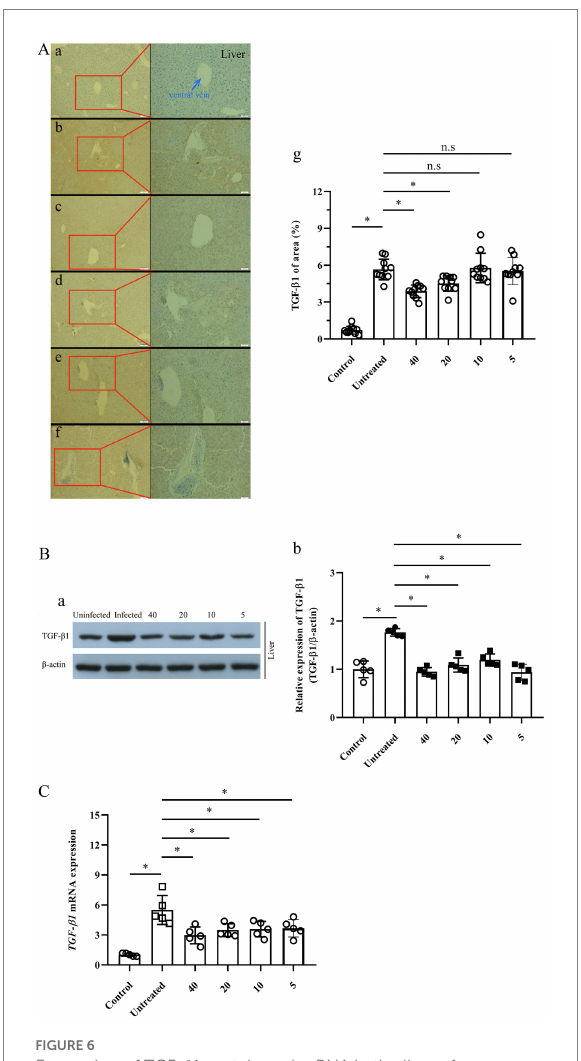
FIGURE 6 Expression of TGF- β 1 protein and mRNA in the liver of Echinococcus -infected mouse after treatment with PAB for 12 weeks, as measured by IHC-P, WB and RT-qPCR assay. (A) Images of TGF- β 1 protein expression in the liver of the mice, (a) uninfected, (b) untreated, and treated with PAB of (c) 40, (d) 20, (e) 10 and (f) 5 mg/kg, as measured by IHC-P assay; and (g) the semi-quantitative analysis of TGF- β 1 protein, as measured by ImageJ software. Brown area indicates expression of TGF- β 1 protein, central vein (blue arrow) in the liver of E. multilocularis - infected mice. Magnification, × 100 and × 200. (B) WB analysis of (a) TGF- β 1 and β -actin expression in the mice liver, and (b) the semi-quantitative analysis of TGF- β 1 protein, as measured by ImageJ software. (C) Analysis of TGF- β 1 mRNA expression in the liver of the mice by RT-qPCR. All data were assessed using One- way ANOVA with multiple